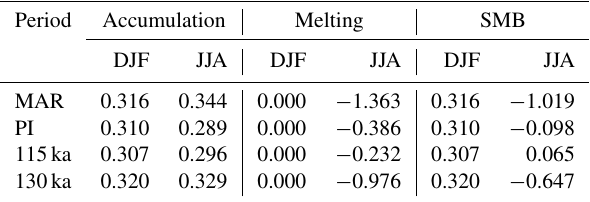
Table 2. Winter (DJF) and summer (JJA) mean accumulation, melt- ing and SMB averaged on the GrIS for the MAR (1980–1999) sim- ulation and for the NPS simulations in the preindustrial period, at 115ka and at 130ka (years 1–280). Units are in mWEyr − 1